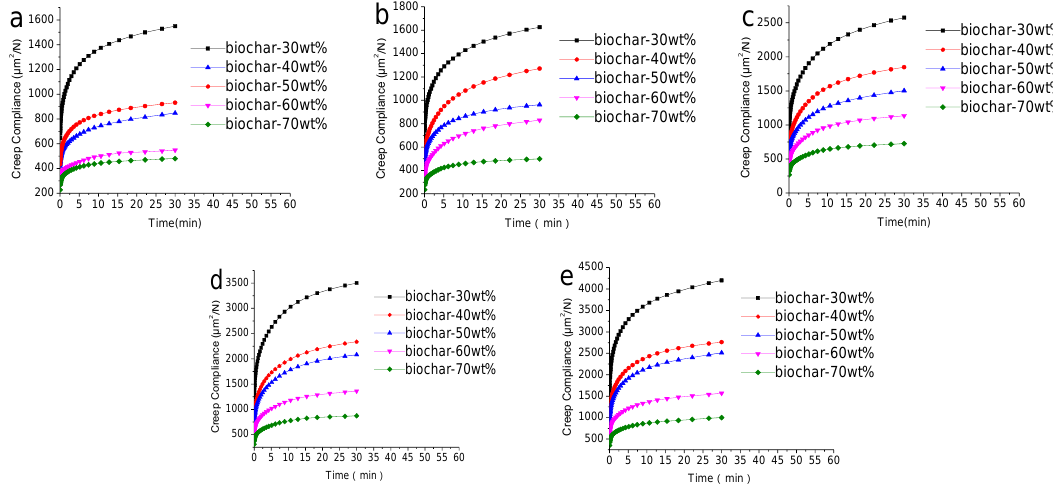
Figure 3. Effects of biochar content on creep behavior at different temperatures: ( a ) 25 °C; ( b ) 35 °C; ( c ) 45 °C; ( d ) 55 °C and ( e ) 65 °C.